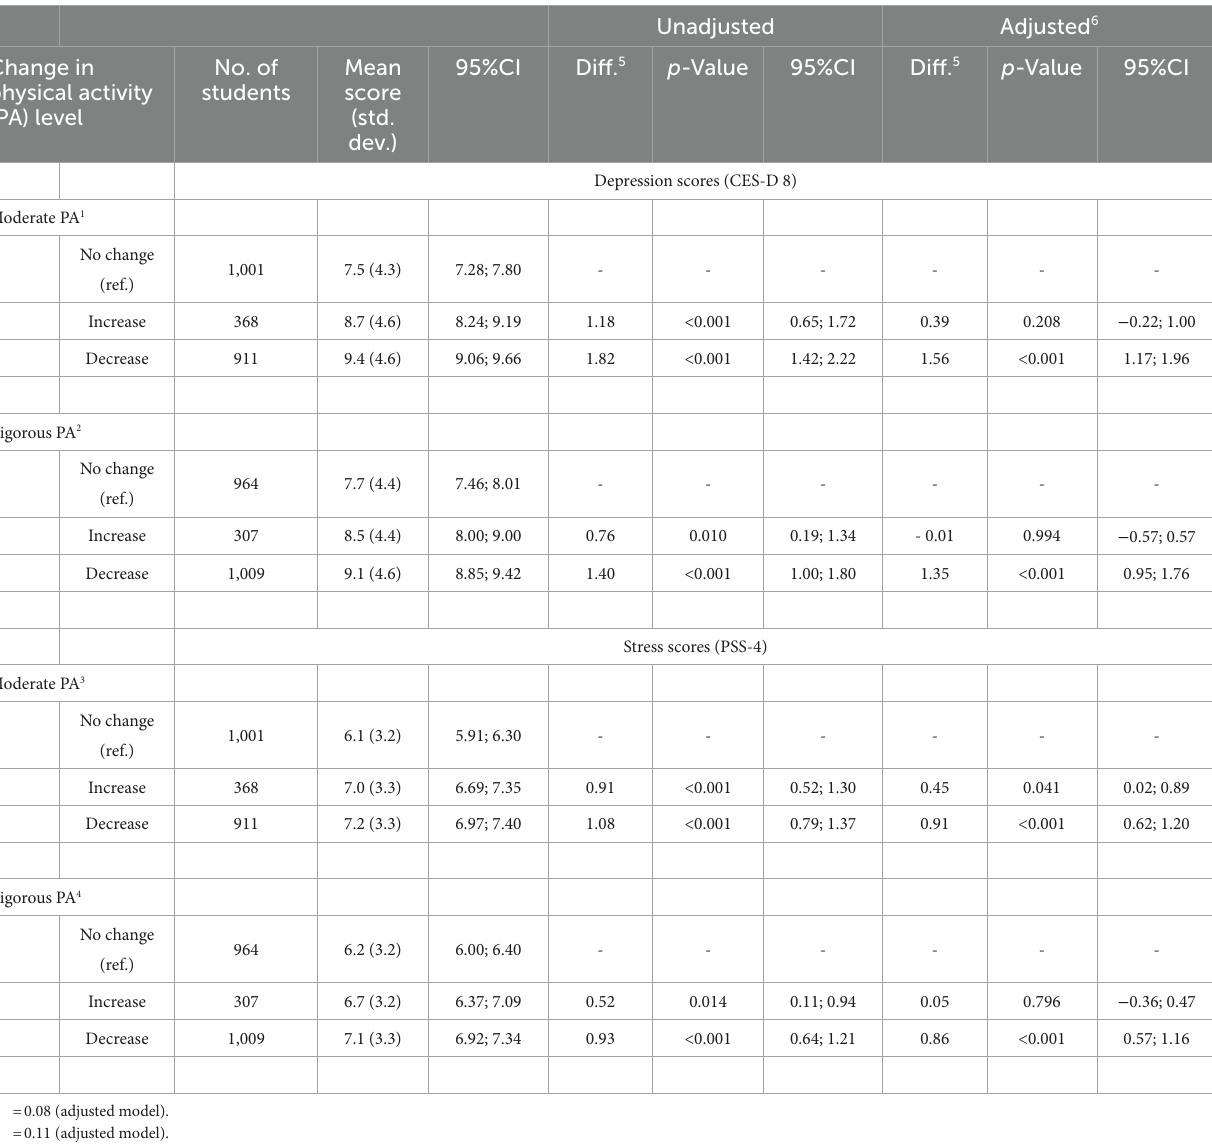
TABLE 3 The association between changes in moderate and vigorous physical activity and depression and stress scores with accompanying value of p and 95% confidence interval, n =